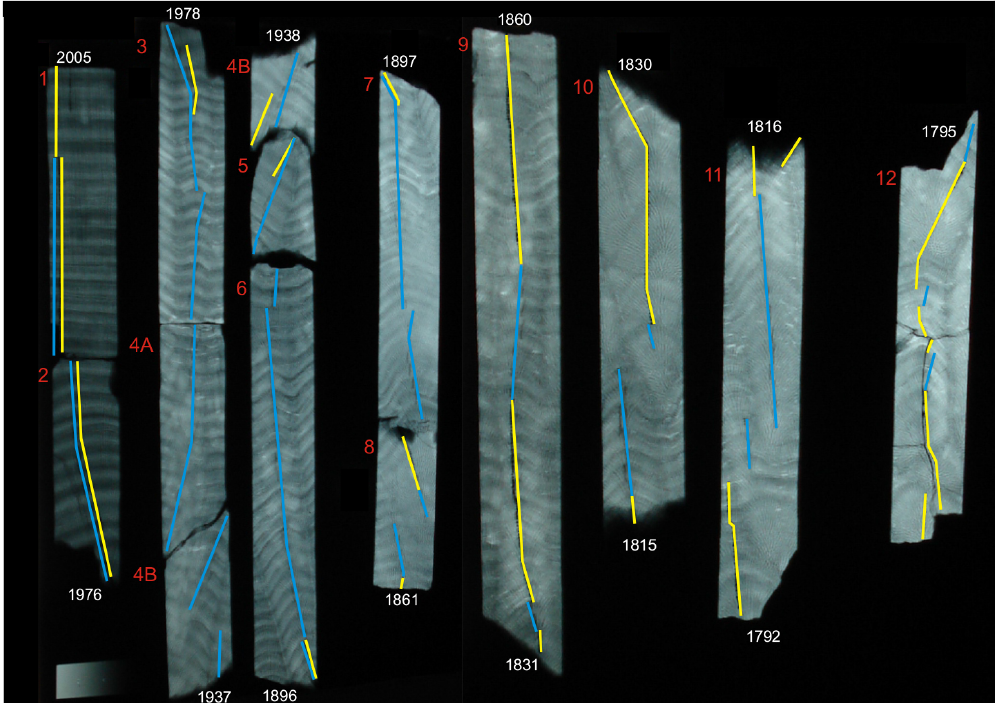
Figure A1. X-ray negative print for core sections of core Totor with sampling lines indicated. Blue lines indicate high-resolution sampling tracks. Yellow lines superimposed on blue lines indicate sampling at annual resolution for other purposes. Start or end years for each core section indicated.